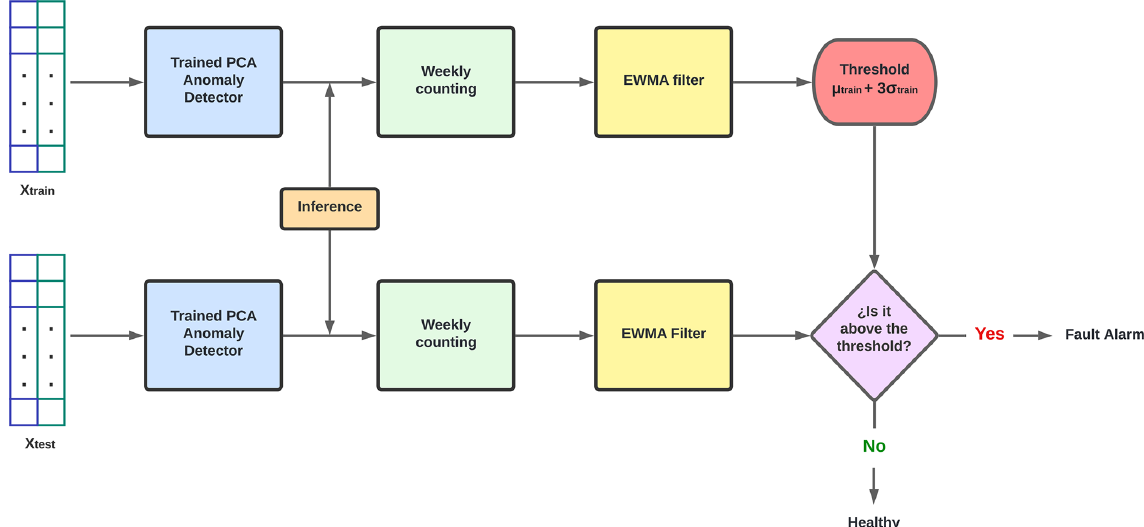
Figure 9. Second phase of the stated